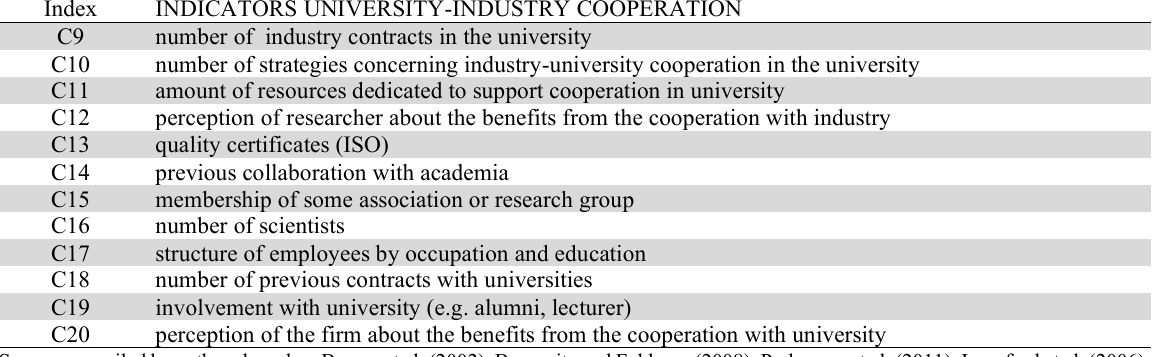
Indicators university-industry cooperation (Continued)